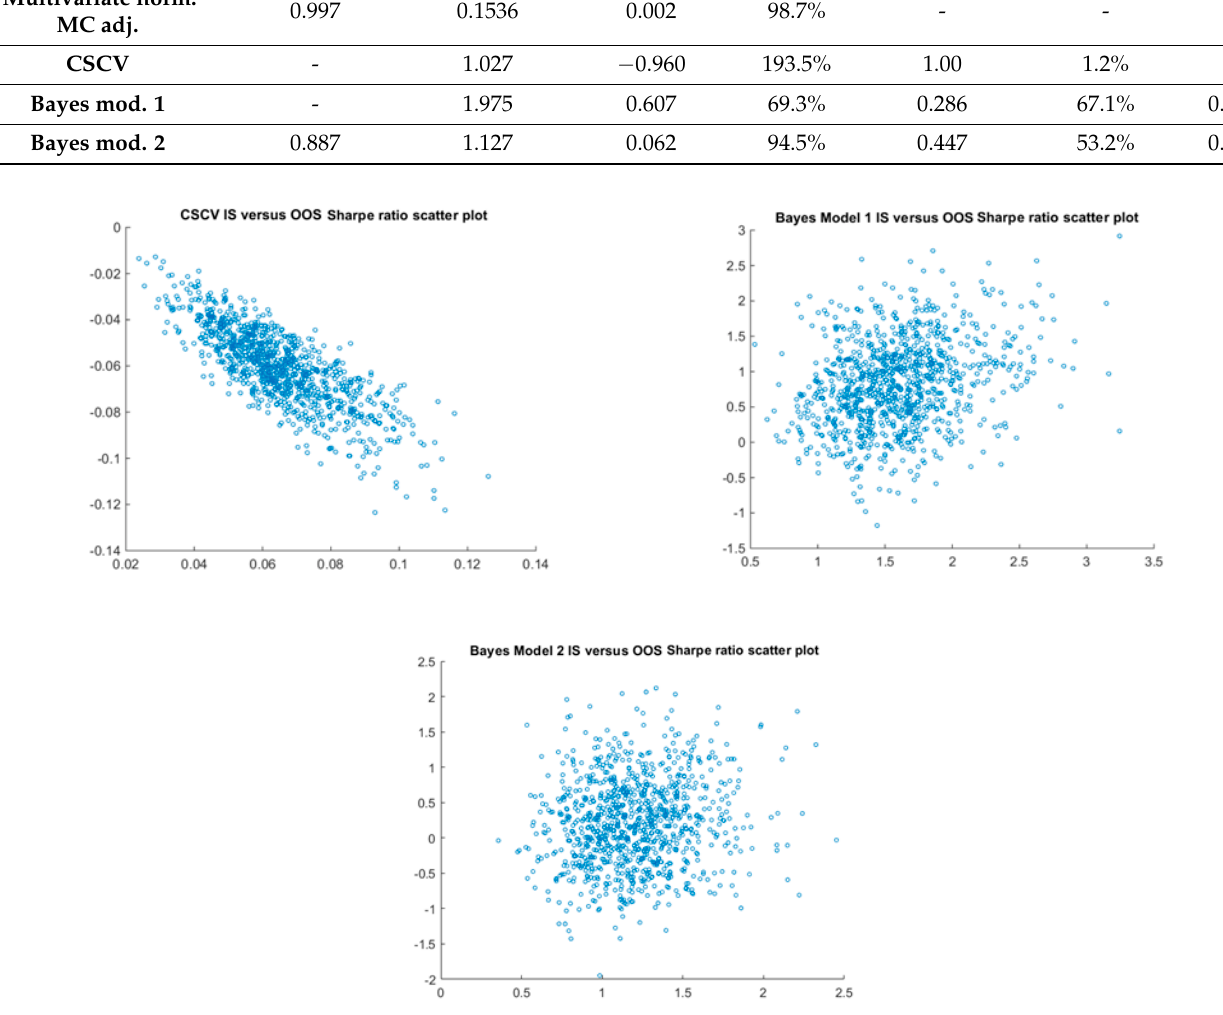
Figure 22. Scatter plots of IS versus OOS Sharpe ratios generated by the three models.